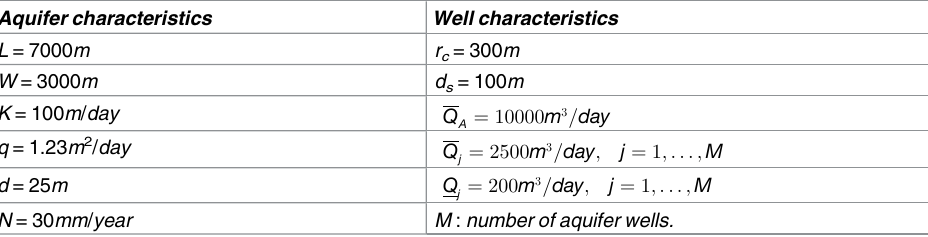
Table 1. Aquifer and well